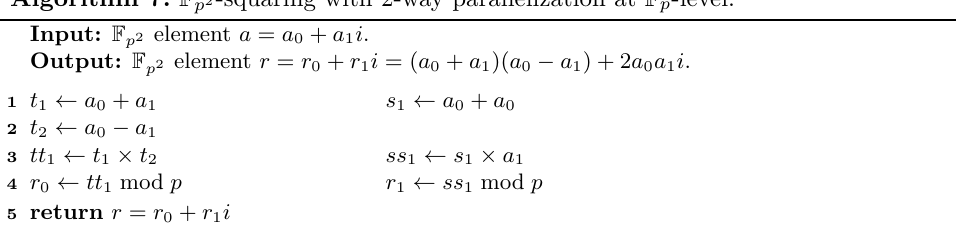
Algorithm 7: F -squaring with 2-way parallelization at F p p 2